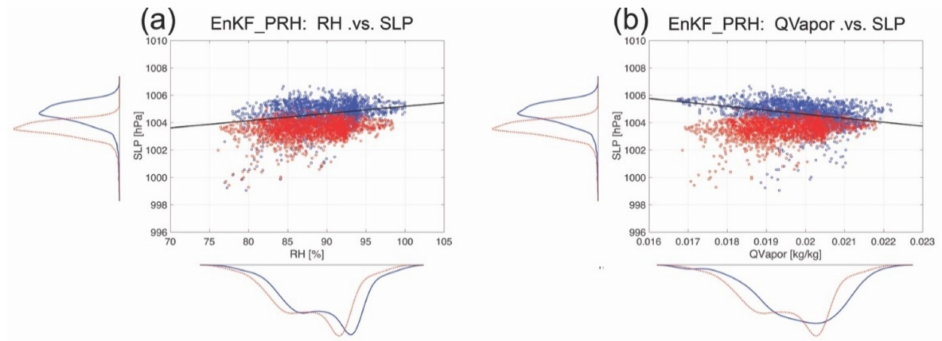
Figure 15. Correlation scatter plots and the projected PDF distributions of the SLP near the TC center (y-axis) and the ( a ) RH and ( b ) mixing ratio (x-axis) at the northwest region of the TC center sampled from the background ensemble forecast (blue dot and blue line) and the EnKF_PRH analysis ensemble (red dot and red line). The black solid line represents the linear regression fit of background ensemble forecast.